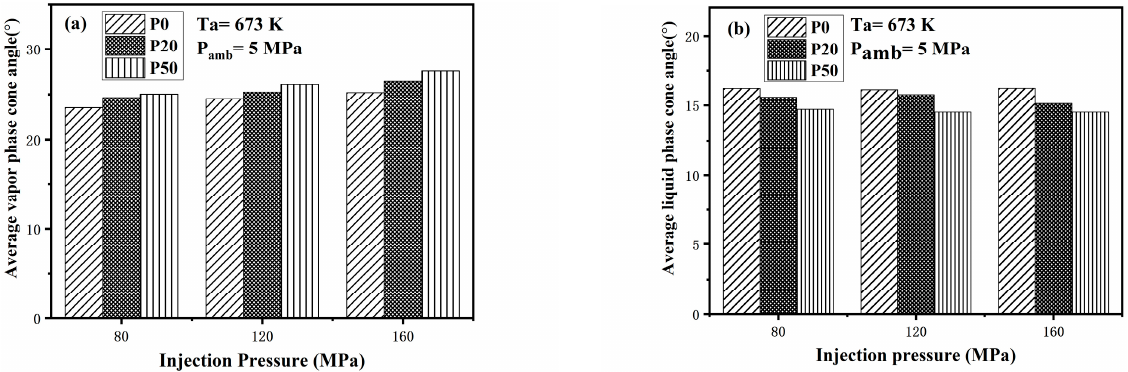
Figure 13. Average cone angles of the three fuels under different fuel Ips: ( a ) average vapor phase cone angle, ( b ) average liquid phase cone angle.